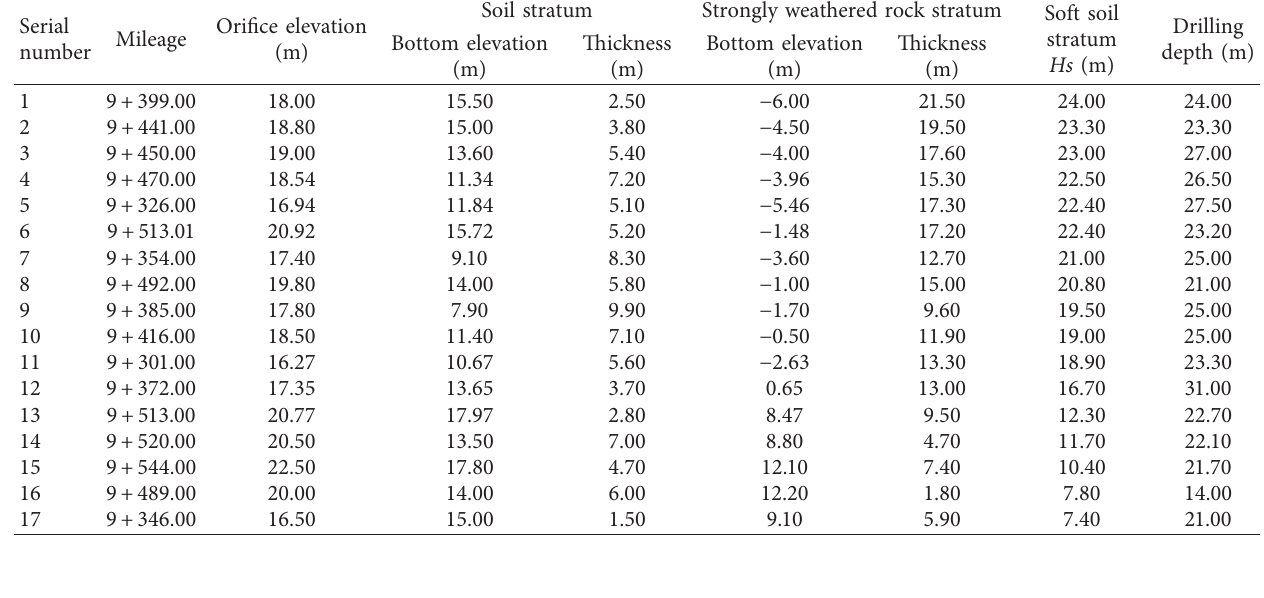
Table 10: Statistical analysis of the project site stratigraphic characteristics.